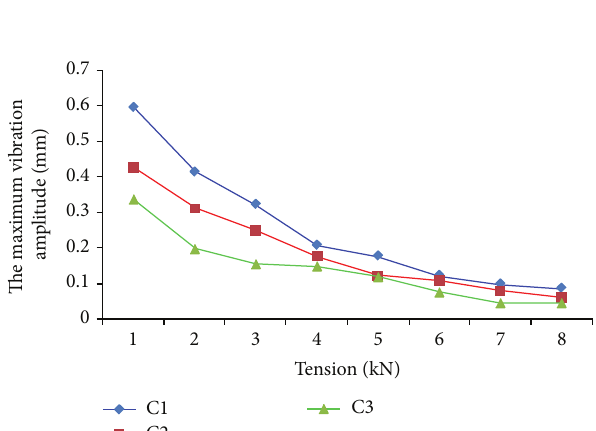
Figure 10: The stress relaxation.